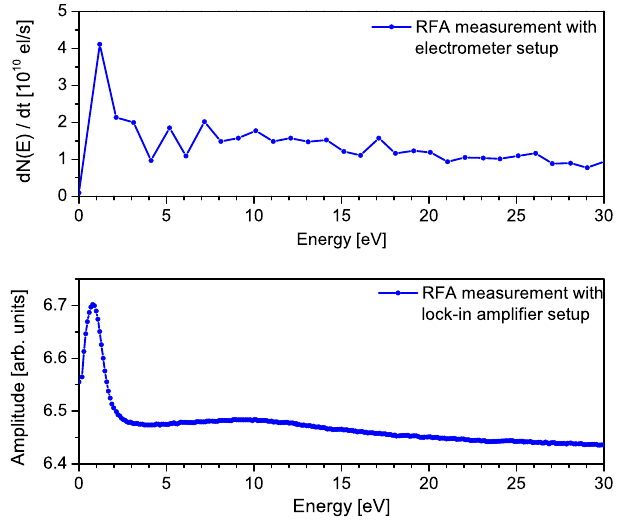
FIG. 10. Comparison of the two RFA readout setups. Energy spectrum obtained by the electrometer (top), and with the lock-in amplifier (bottom), of the low energy electrons hitting the detector and generated by a hot filament in a laboratory